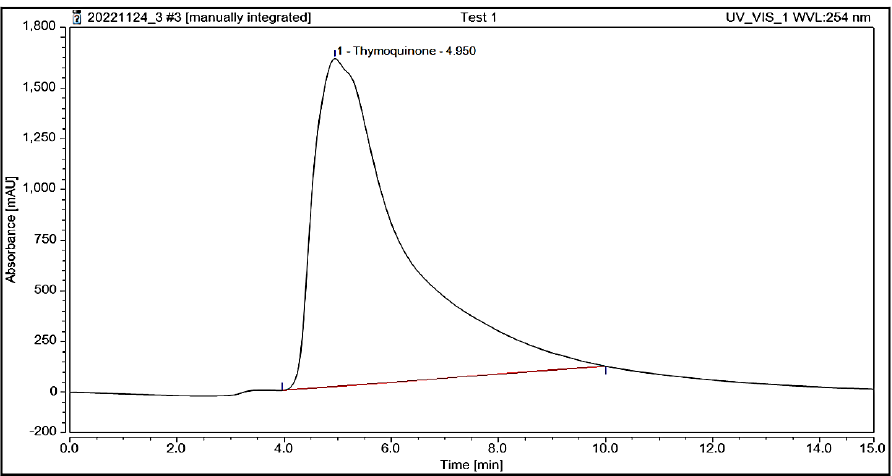
Figure 7. High-performance liquid chromatogram of thymoquinone in black seed oil.